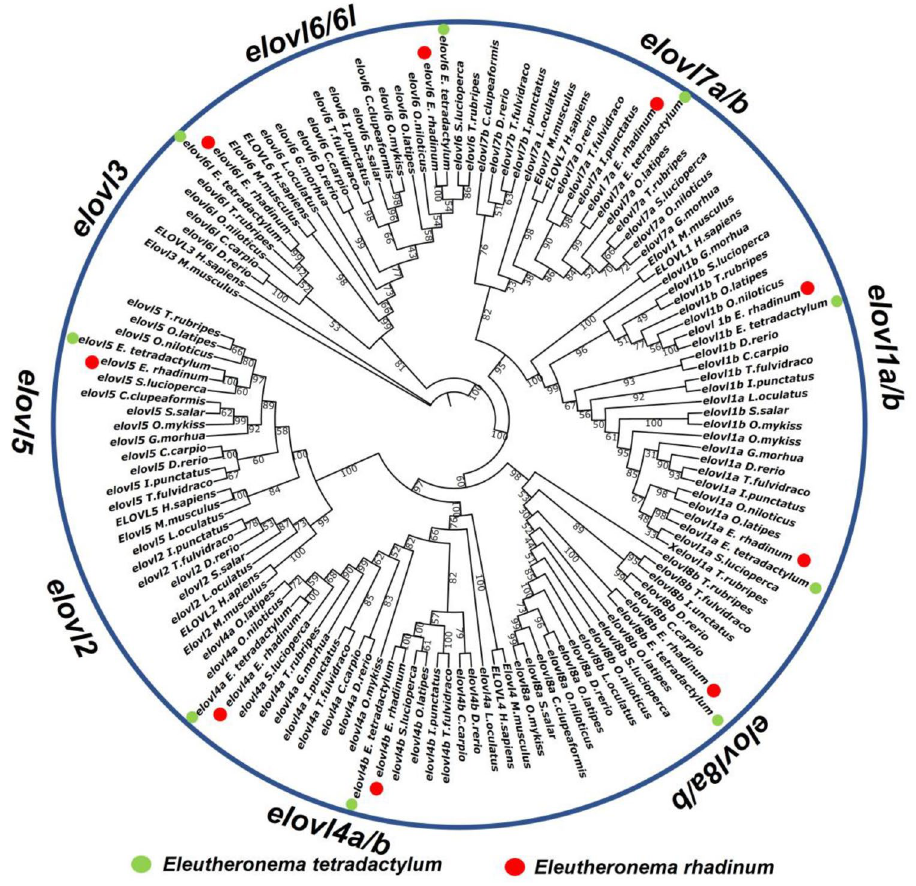
Figure 1. Phylogenetic tree for 18 Elovl proteins from E. tetradactylum and E. rhadinum , and 106 publicly available Elovl proteins from other species. All these proteins were aligned using ClustalW and then subjected to MEGAX for phylogenetic tree construction using the maximum like-hood method with 1000